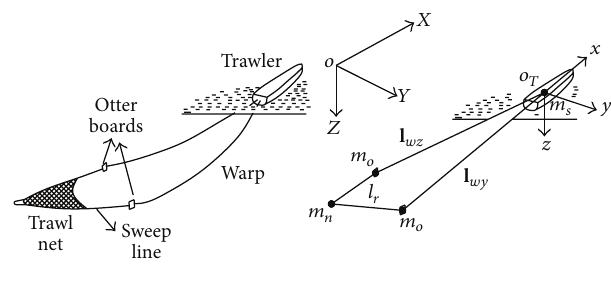
Figure 1: Simplified trawl